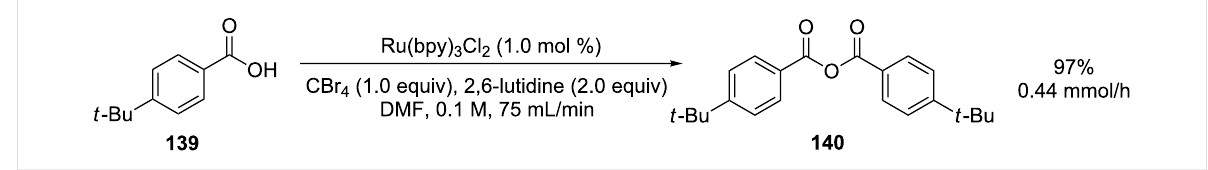
Scheme 48: Anhydride formation from a visible-light-mediated process.